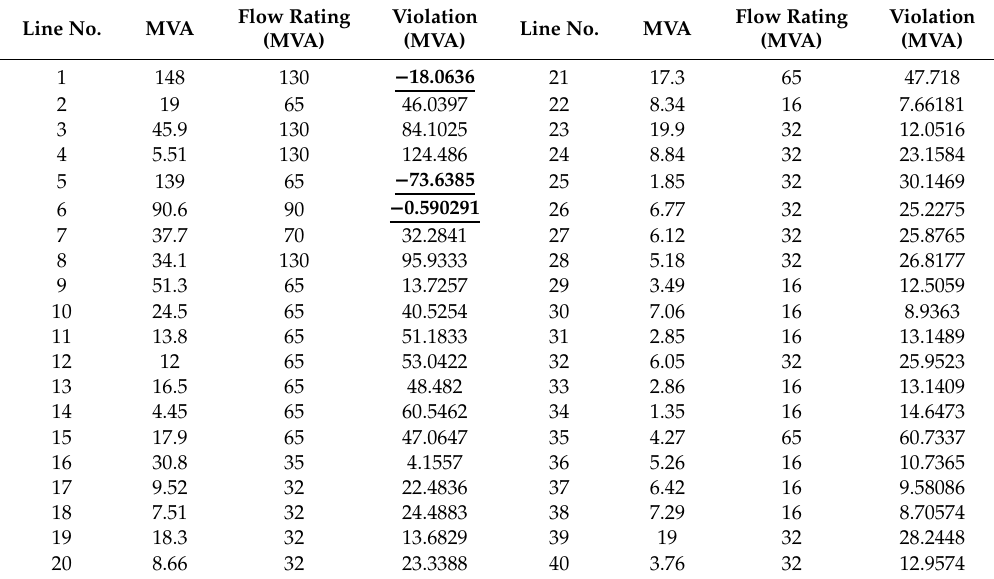
Table 2. Impact on network framework parameters due to outage of lines